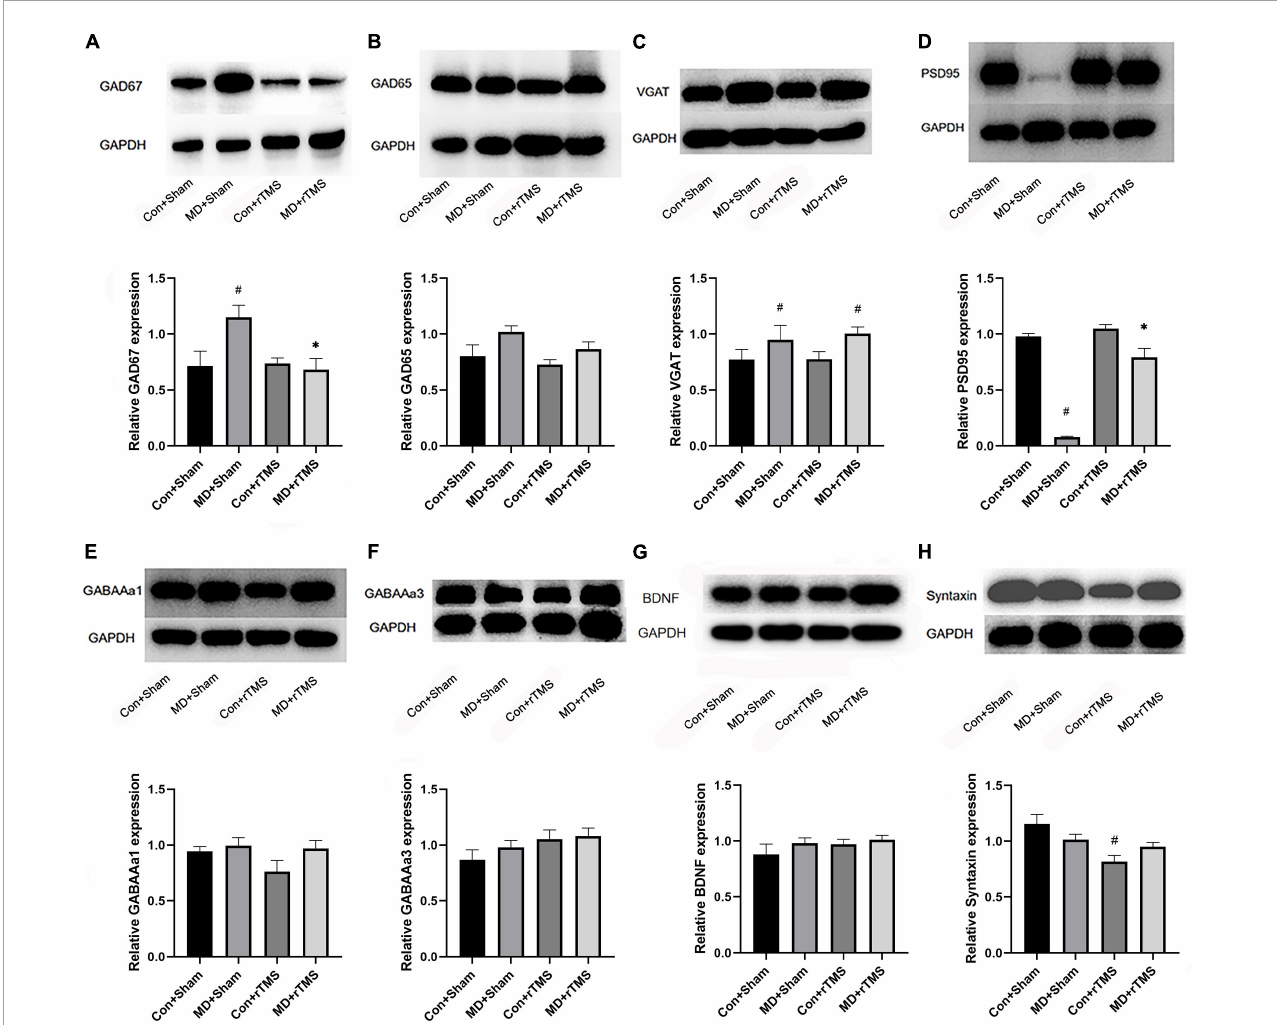
FIGURE5 Western blot to detect the expression of the inhibitory neural pathway proteins and synapse-related protein in the binocular area of the visual cortex of rats in each group. (A–H) Shows the relative expression of GAD67, GAD65, VGAT, PSD95, GABAA α 1, GABAA α 3, BDNF, and Syntaxin, respectively. The upper panel of each figure is the electrophoresis band, and the lower is the statistical analysis diagram of the relative ratio of the target protein and the internal reference protein glyceraldehyde-3-phosphate dehydrogenase (GAPDH) in each group, as assessed by two-way analysis of variance (ANOVA). # Indicated a statistically significant difference compared to the Con+Sham group after accepting stimulation, p < 0.05; ∗ indicates the significant difference compared to the MD+Sham group following receiving stimulation, p <